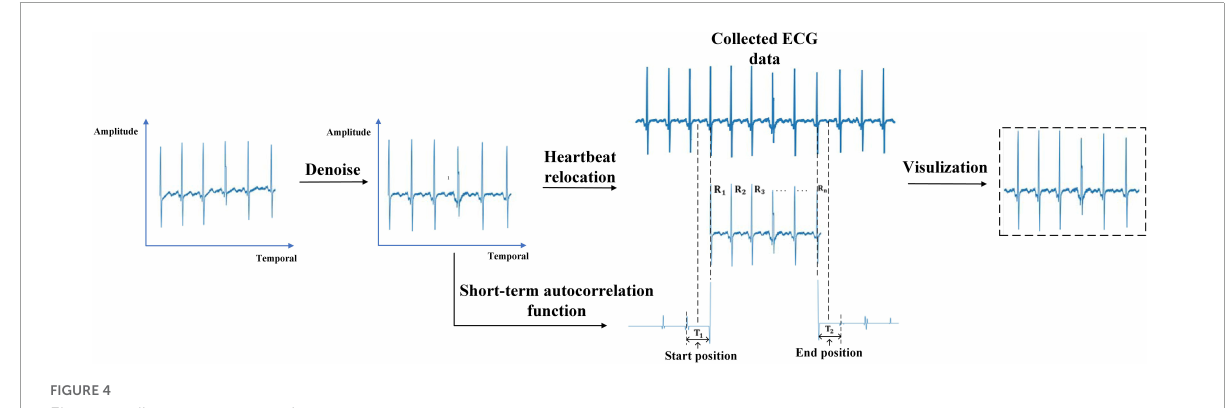
FIGURE4 Electrocardiogram